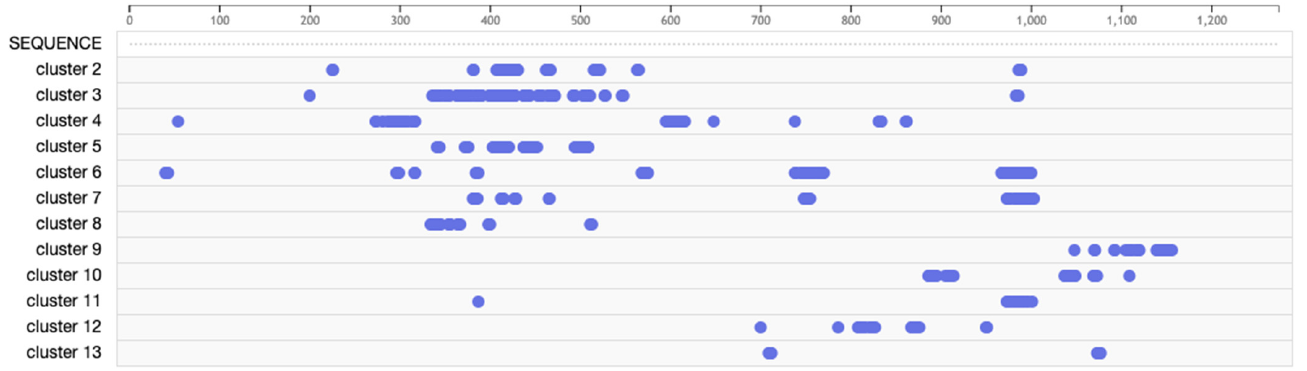
Figure 5. Amino acid residues corresponding to each identified functional cluster.